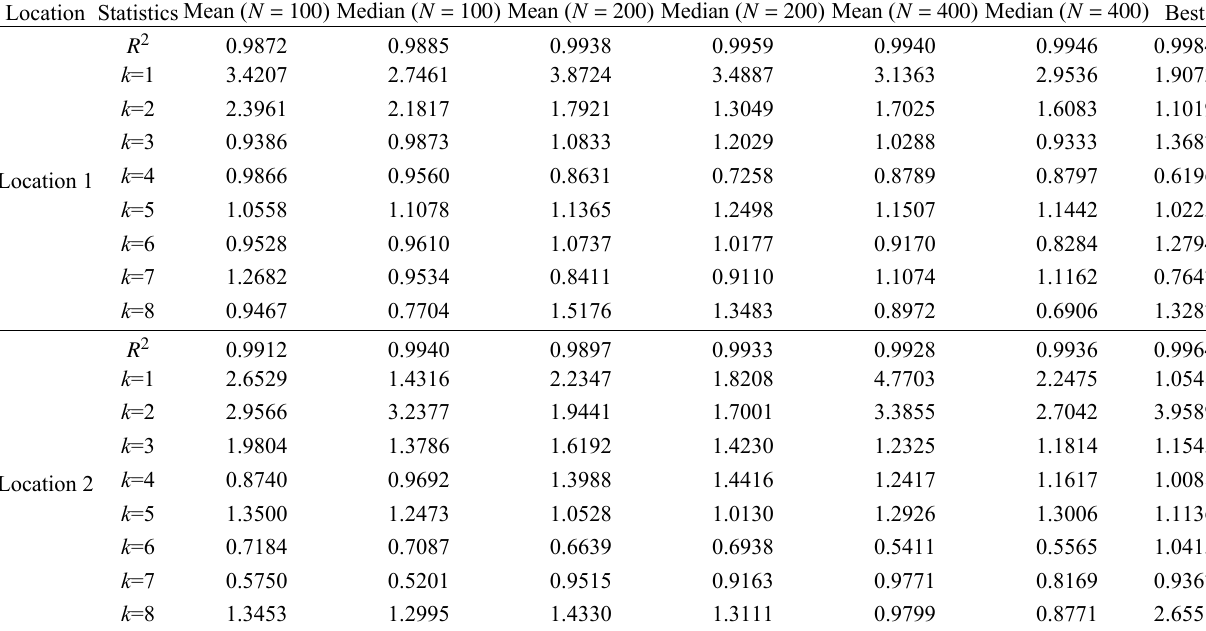
∆ t = 1 Table 5 Reproduction number (refer to Eq. (4)), week, PSO.